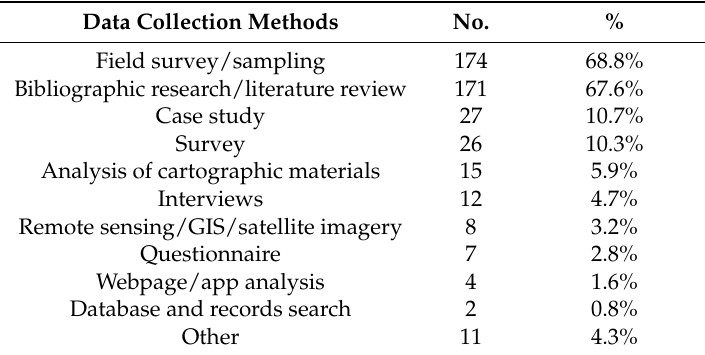
Table 4. Data collection methods employed in the reviewed